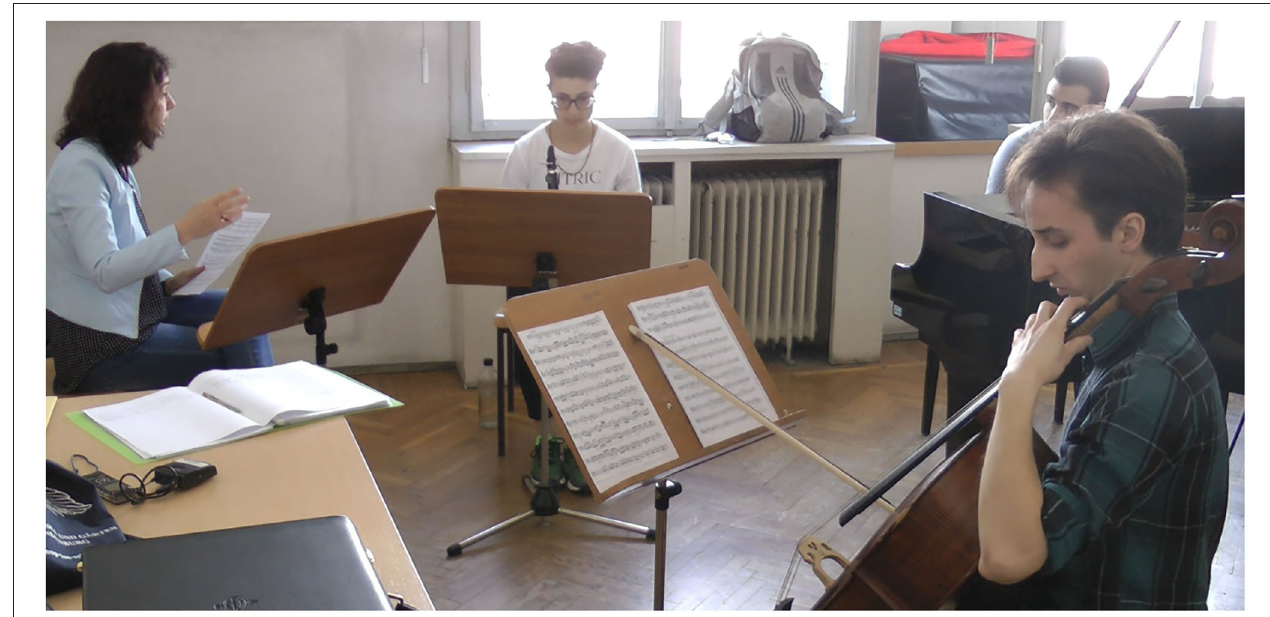
FIGURE 3 | Professor moves right hand outwards.